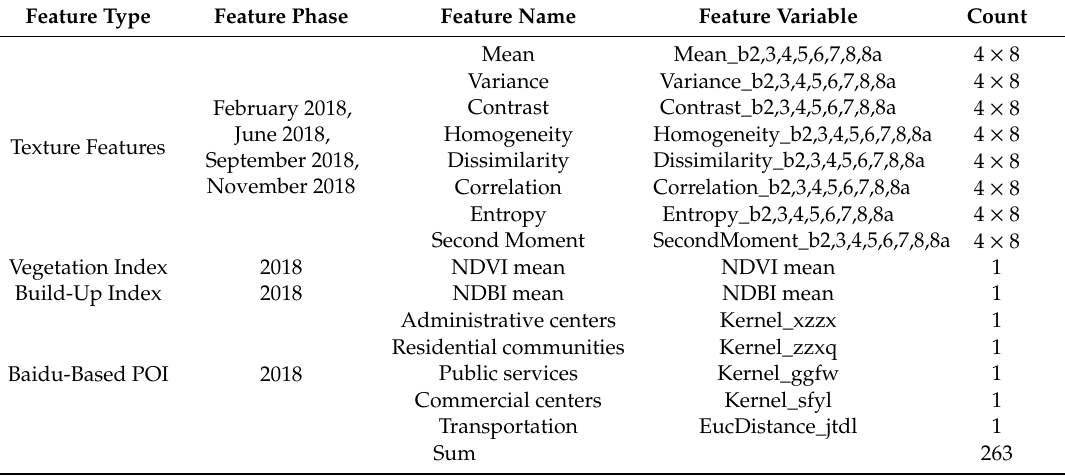
Figure 4. Spectral curves of the three types in the study area on ( a ) 22 February 2018, ( b ) 7 June 2018, ( c ) 30 September 2017, and ( d ) 19 November 2018. Table 2. Feature parameters extracted from the four Sentinel-2 images and POI features.